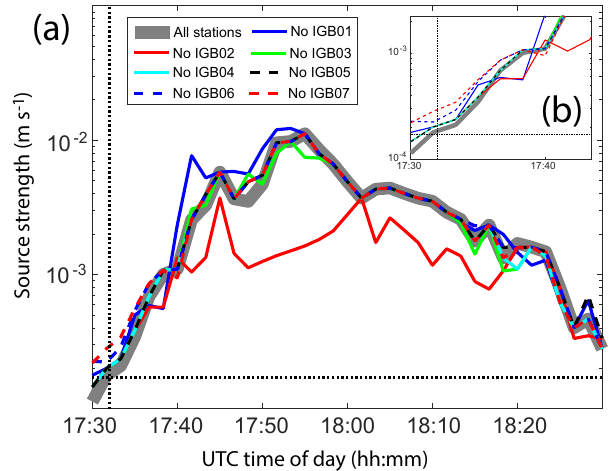
Figure 11. (a) Variations in calculated source strength A 0 as in- dividual stations are removed. Vertical and horizontal bars indi- cate earliest detection time at 17:32UTC and proposed threshold, respectively. (b) Magnification of near-earliest detection time at